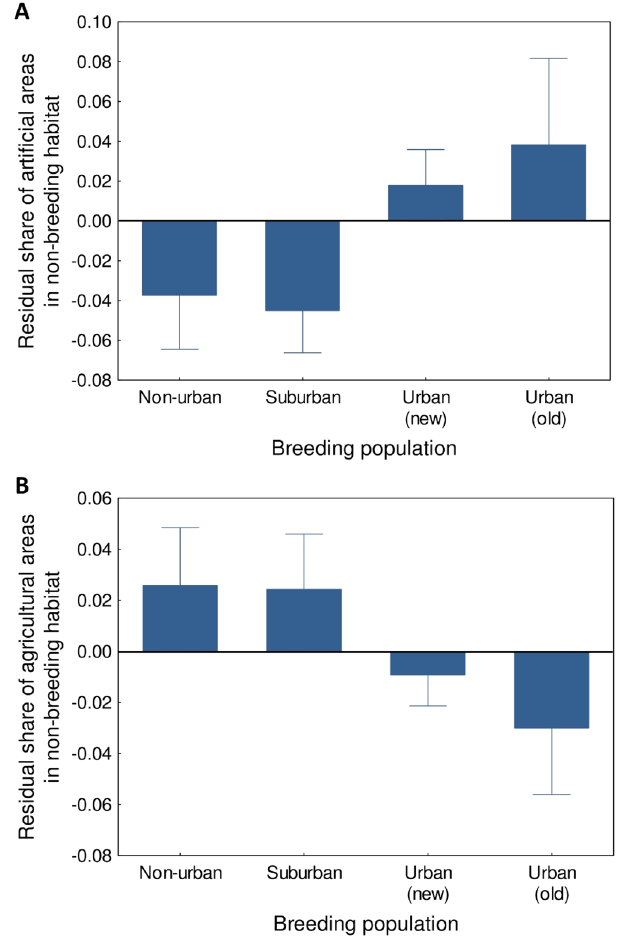
Figure 2. The share of artificial ( A ) and agricultural ( B ) areas in non-breeding habitats (0.5 km scale) selected by Eurasian coots from different breeding populations in central Poland. Residuals from general linear mixed models (means ± SE) are